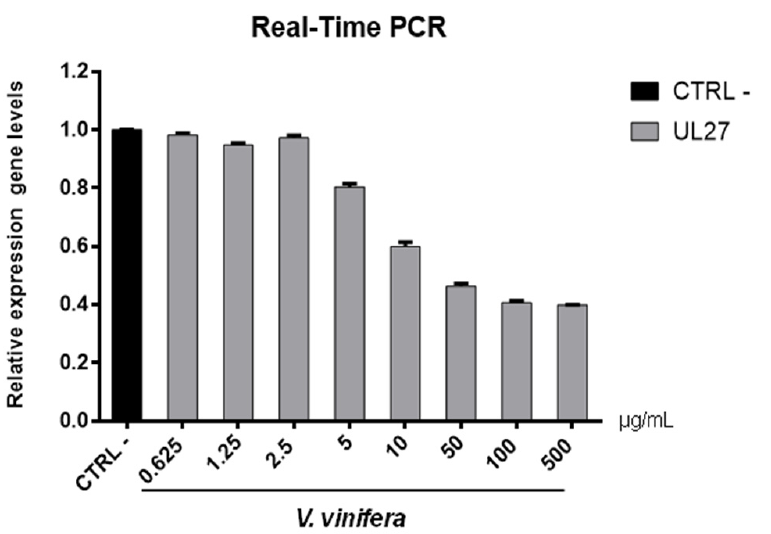
Figure 7. UL27 (glycoprotein B) gene expression analysis in Vero cells. V.vinifera leaf extract at 0.625, 1.25, 2.5, 5, 10, 50, 100, and 500 µ g/mL was incubated with HSV-1 for 1 h and then, the mixture was added on Vero cells for another 1 h. After 2 days post-infection, RNA was extracted and Real-Time PCR was performed. Relative expression gene level was calculated with respect to CTRL − . Regarding the HSV-1 antiviral effect, UL27 gene, a late gene coding for the structural glycoprotein B (gB) was quantified via molecular assay (Figure 7). In brief, a virus pre- treatment assay was performed, as previously mentioned, and RNA was collected after 48 h post-infection. Results showed that the extract inhibited HSV-1 replication by block- ing much of viral gene expression, which almost halved at a concentration of 10 µg/mL. The outcomes on the replication are in accordance with literature [67–71], demonstrating that the leaf extract had a virucidal action and could be used as a prophylactic treatment